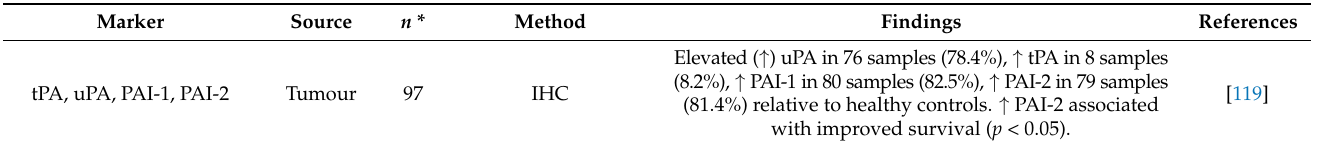
Table 1. Summary of uPAS expression in human pancreatic cancer tissue samples. Generally, IHC and ELISAs have been the most utilised techniques to assess uPAS protein or mRNA expression levels in patient tumour tissue and